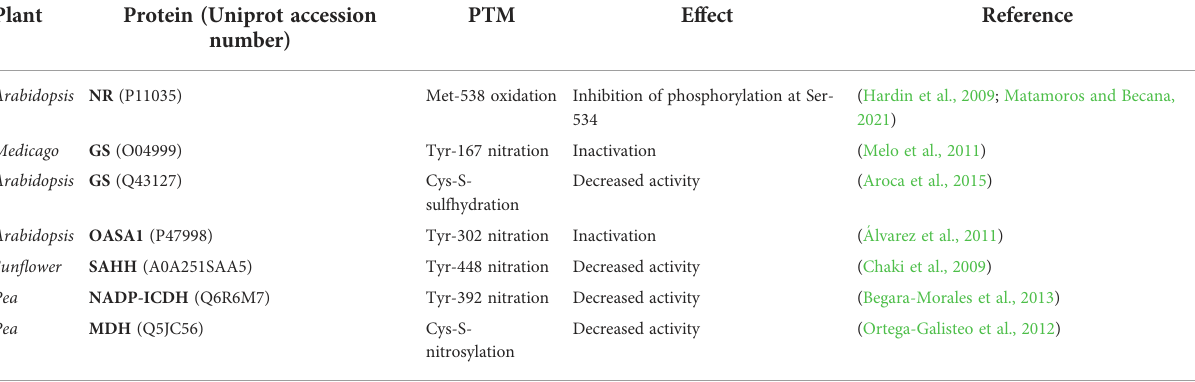
TABLE 2 PTMs and their effect on the different primary metabolism-related proteins subject to redox regulation.